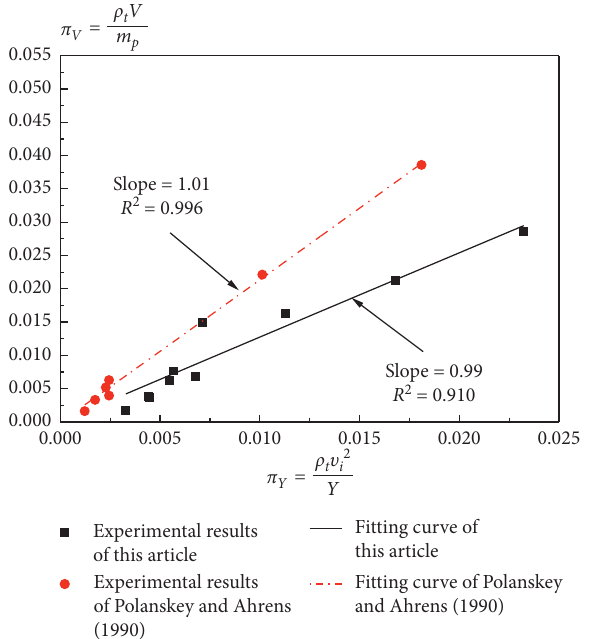
Figure 16: The relation between dimensionless π the momentum